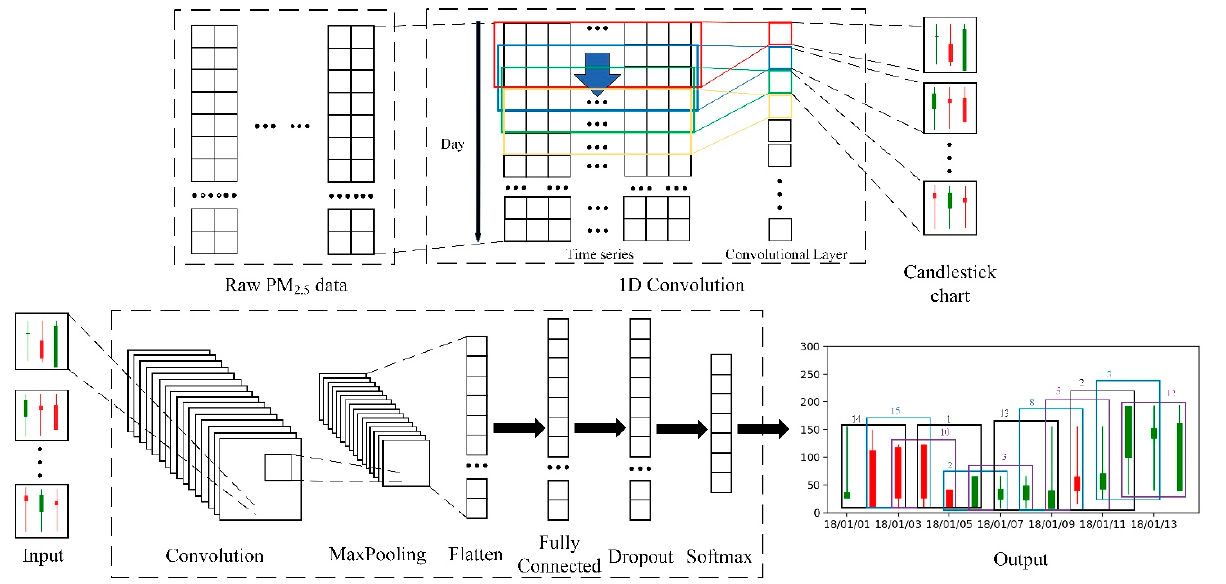
Figure 8. Architecture of the constructed VGG model. Figure 9. Architecture of the constructed VGG